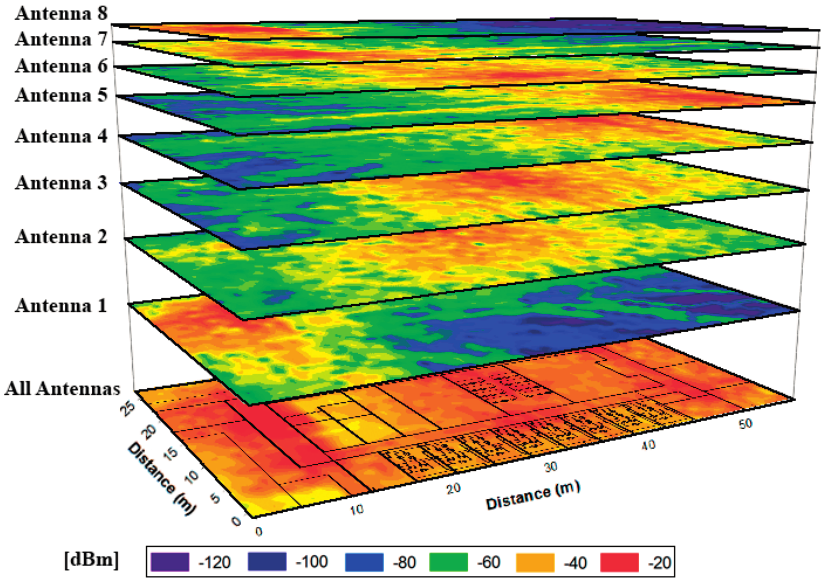
Figure 5. RF power contribution of the simulated antennas for the plane at height = 1 m, individually as well as the total power distribution (bottom plane).